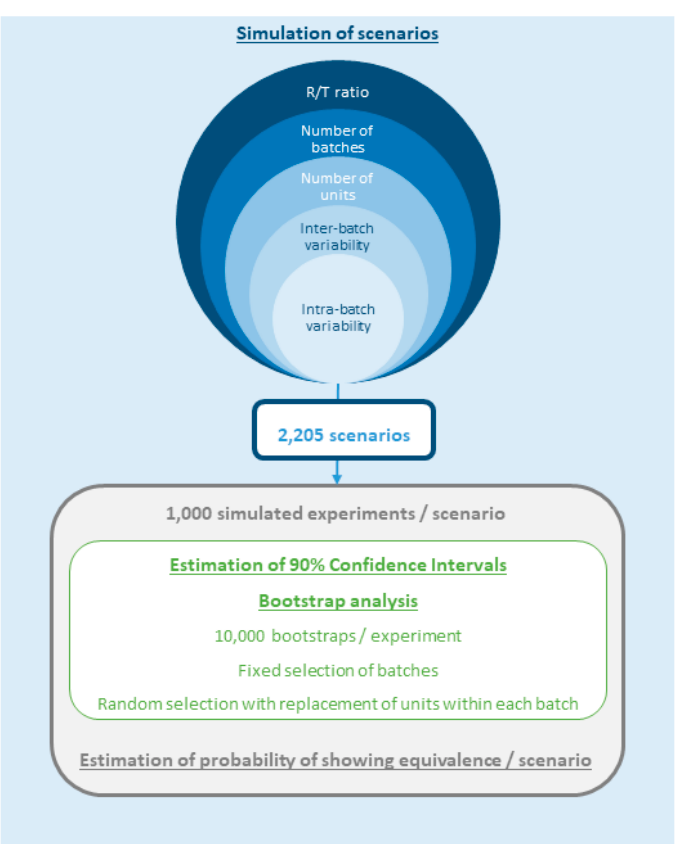
Figure 1. The simulation workflow applied to (i) simulate the scenarios, and (ii) estimate the probability of declaring equivalence per scenario.